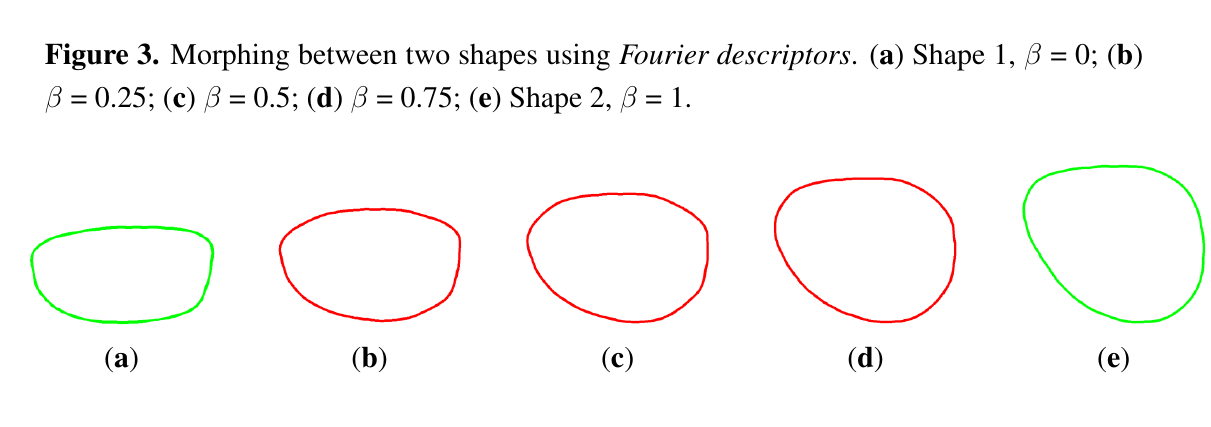
Figure 3. Morphing between two shapes using Fourier descriptors . ( a ) Shape 1, β = 0; ( b